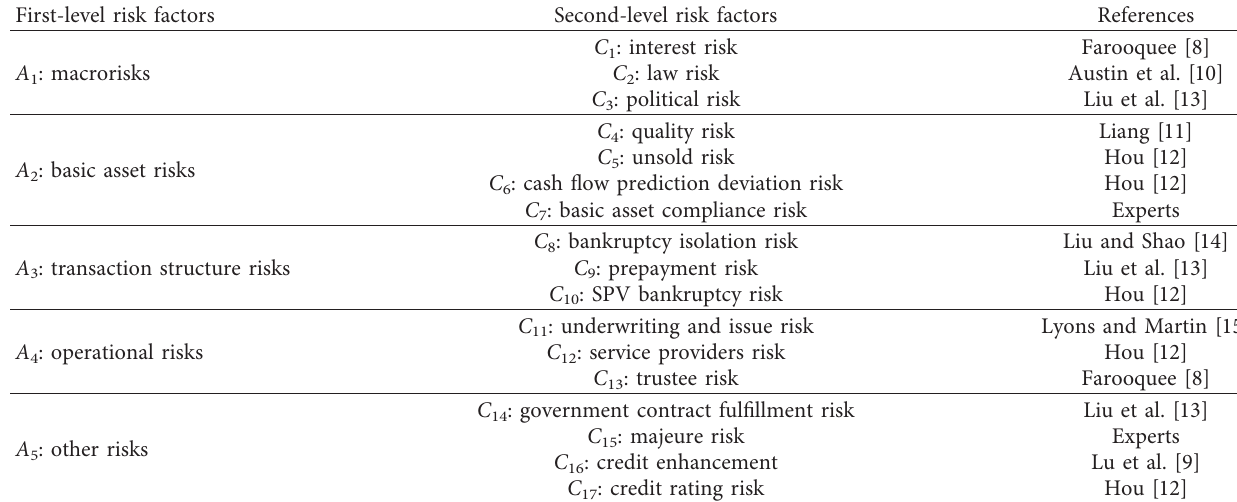
Table 3: Final risk system of sewage treatment PPPABS